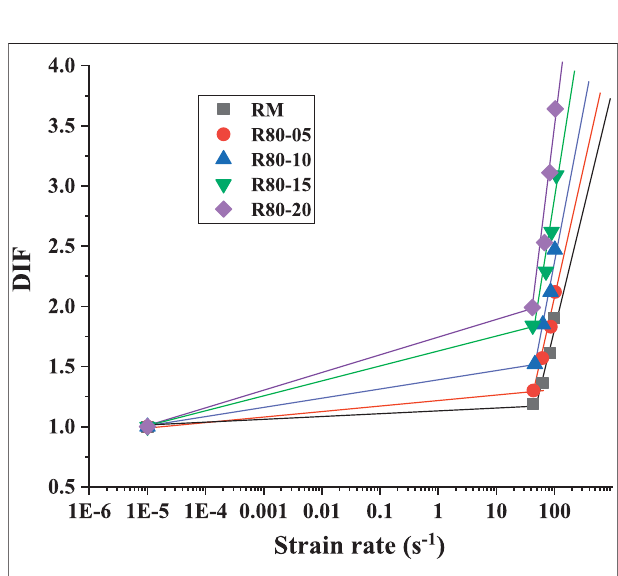
FIGURE 15 | Regression function of DIF and strain rate.